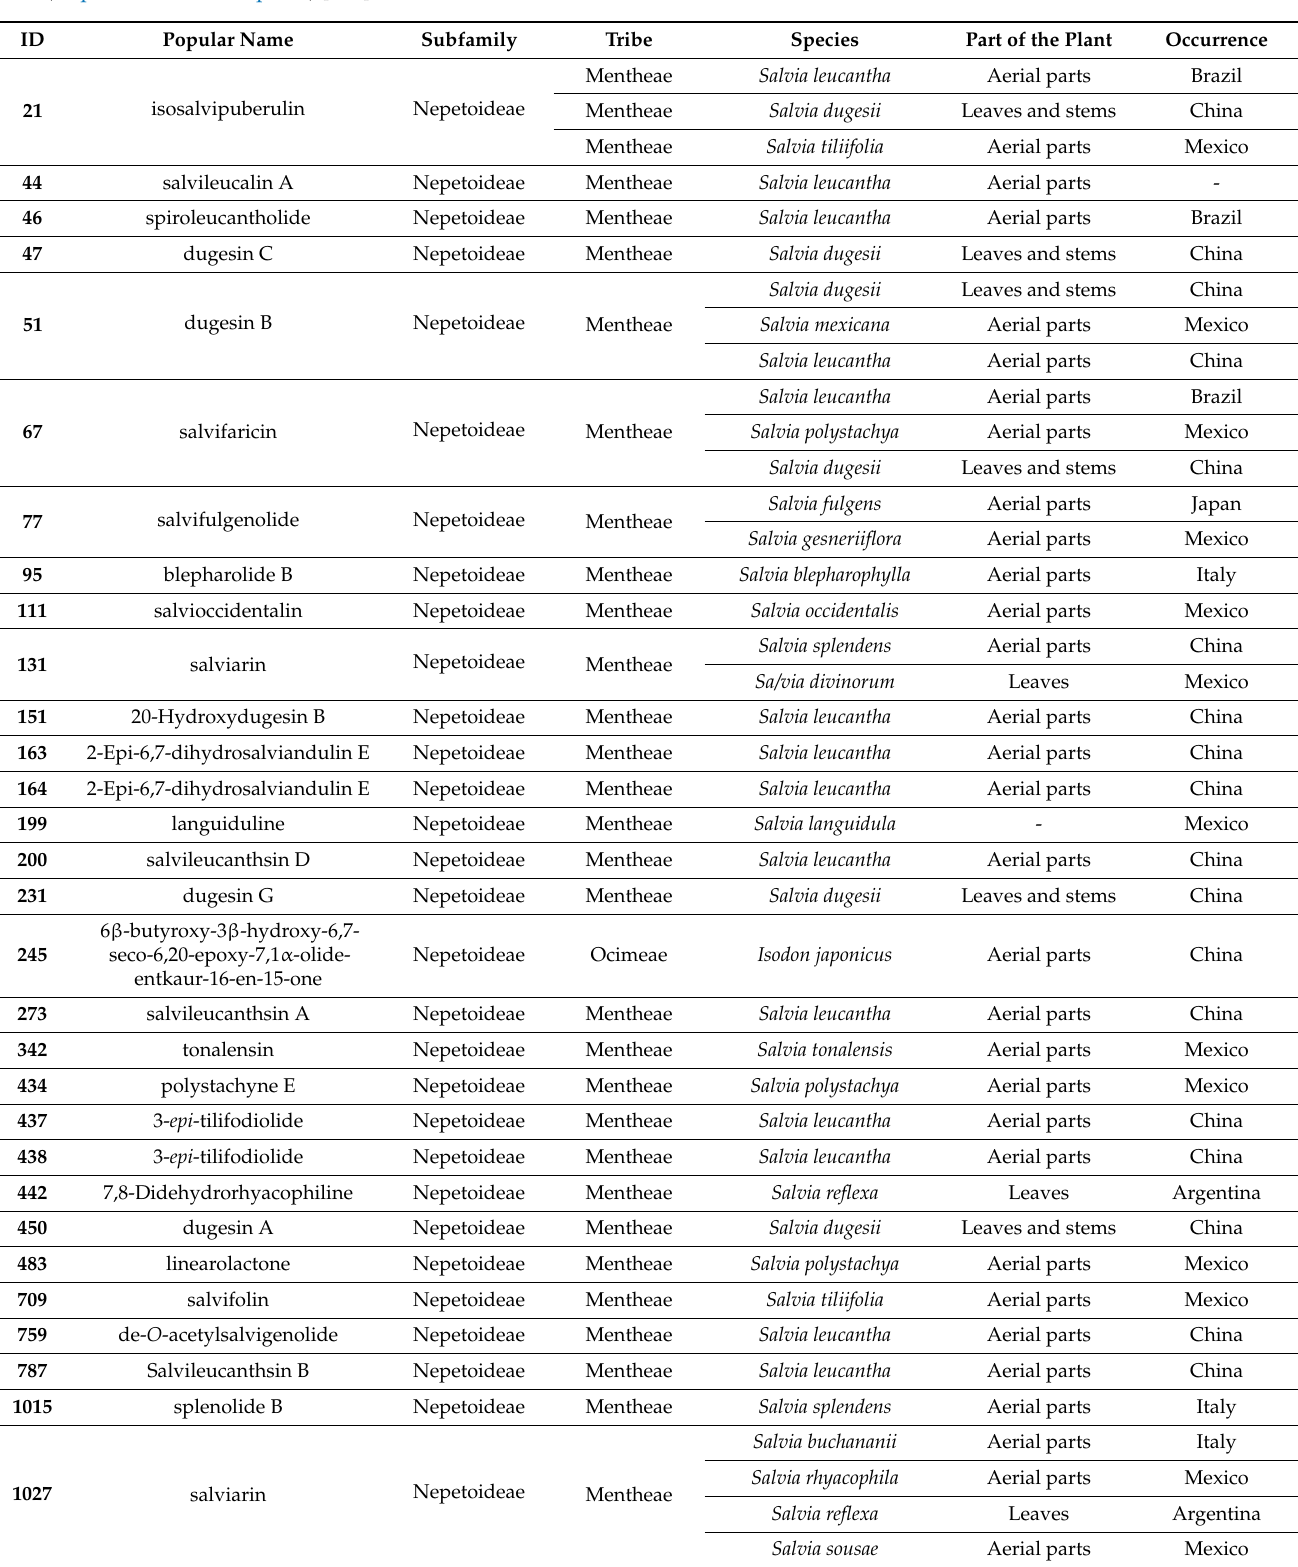
Table 7. Distribution of diterpenes considered active against D. melanogaster with information on the subfamily Nepetoideae (Lamiaceae) listed by tribe, genus, and species, and presenting plant data and occurrence is available on the SistematX (https://sistematx.ufpb.br)